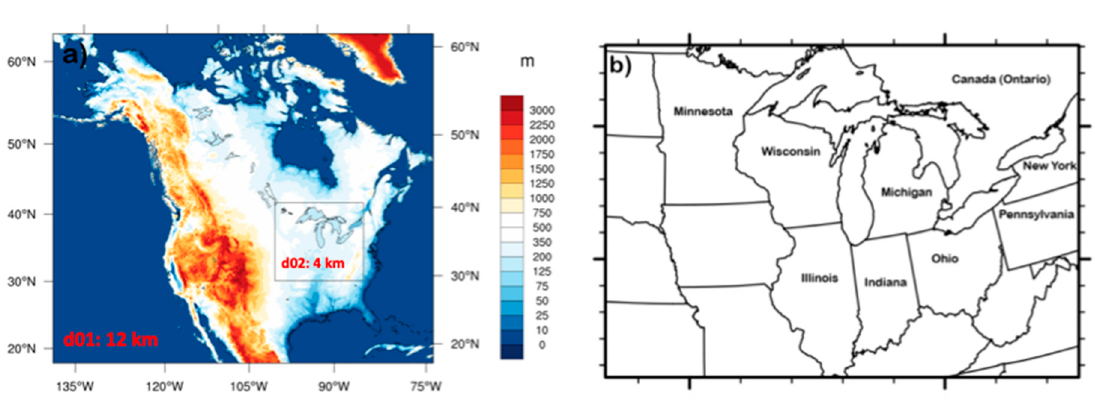
Figure 1. ( a ) Two-way nested domains for the Weather Research and Forecasting model (WRF) model with a grid size of 12- and 4-km as d01 and d02 respectively, overlaid on a terrain height map; and ( b ) a map showing the states in the U.S. and Canadian province Ontario surrounding the Great Lakes. Time-varying, large-scale, 6-hourly National Center for Environmental Prediction (NCEP)-U.S. Department of Energy (DOE) Atmospheric Model Intercomparison Project II reanalysis datasets (NCEP-R2) [64] at T62 Gaussian grids and 17 pressure levels were applied as lateral boundary